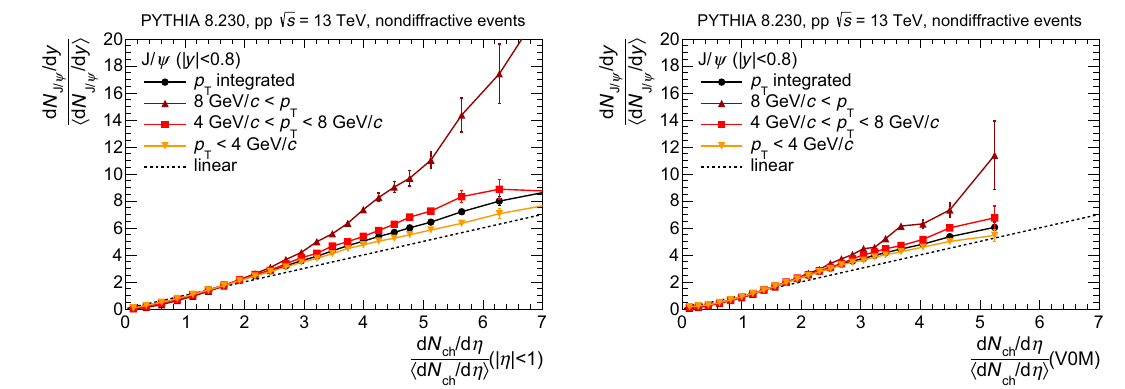
Fig. 7 Mid-rapidity J /ψ production as a function of charged-particle multiplicity at mid (left) and forward (right) rapidity in different p T intervals